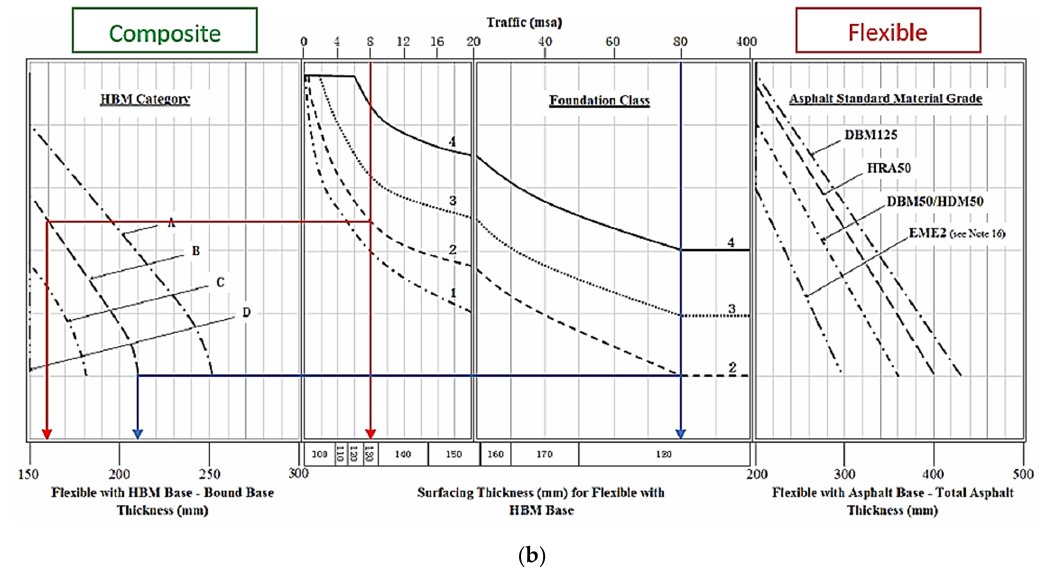
Figure 7. ( a ) Class 3 design—single foundation layer (Interim Advice Note (IAN) 73/06) [19]; ( b ) nomograph for determining the design thickness for flexible pavement (Design Manual for Roads and Bridges (DMRB) CD 226) [17] . Table 3. Examples of hydraulic bound base materials (HBM) (DMRB CD 226) [17] .